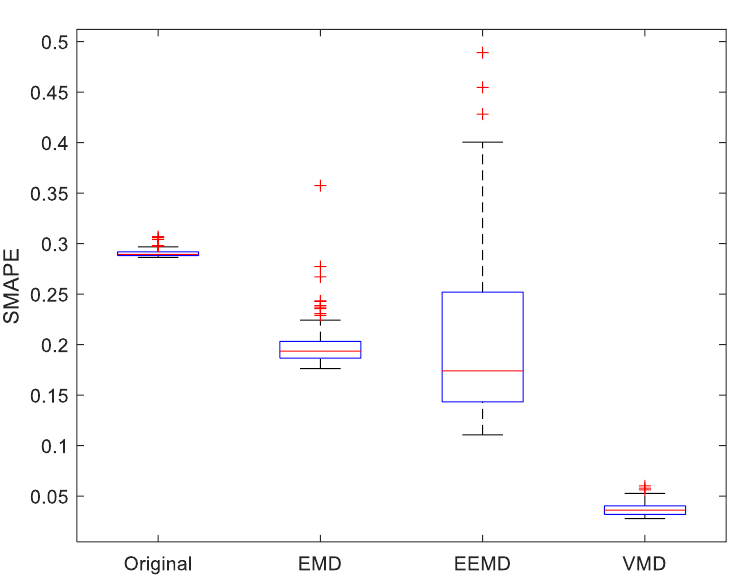
Figure 10. Accuracy results of different decomposition methods.